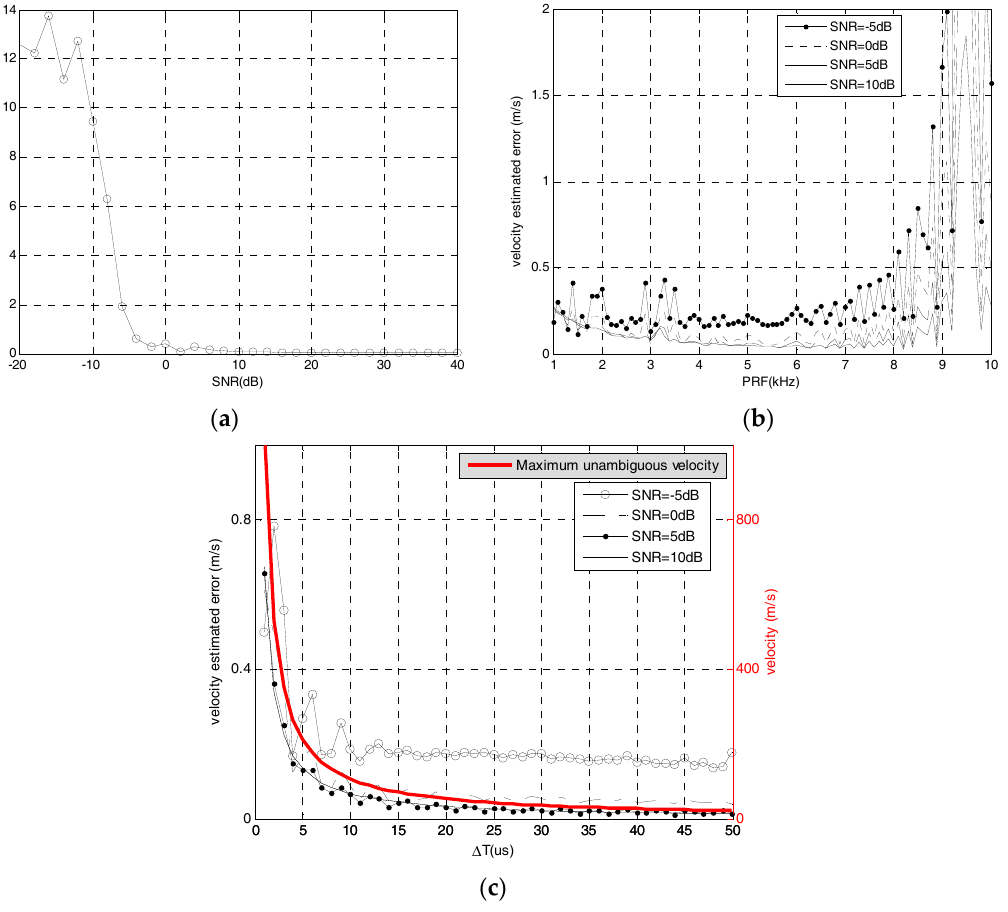
Figure 5. The influence of PRF, the signal to noise ratio (SNR), and Δ T on the velocity estimation error. Velocity estimation deviation was determined with Monte-Carlo statistical tests for 1000 repetitions. ( a ) Velocity estimation error under different SNR; ( b ) velocity estimation error with different PRF and ( c ) velocity estimation error with different Δ T and SNR.